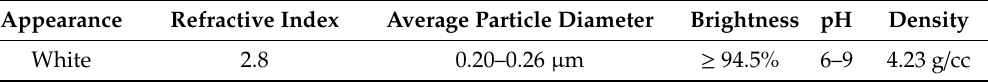
Table 1. Technical characteristics of titanium oxide.